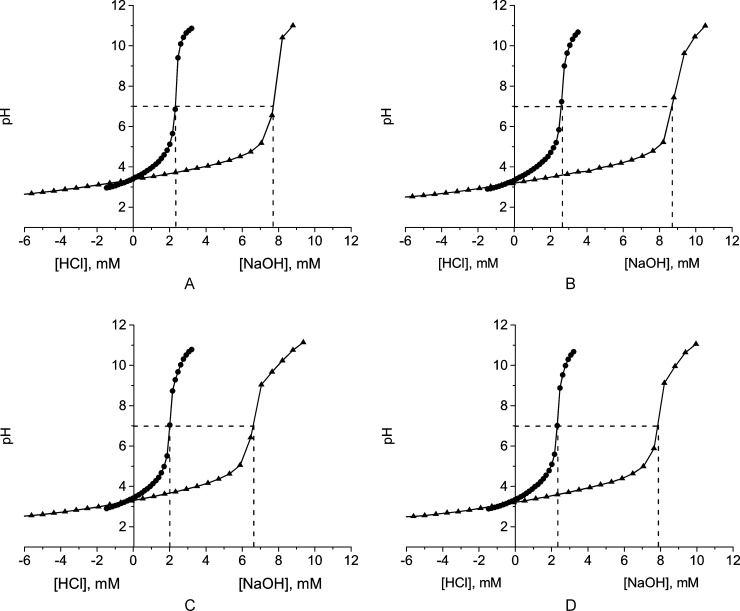
Acid-base titration curves of 0.3 (circle) and 1.2% (triangle) solutions of pectins from different sources.A–pumpkin pectin PP, B–citrus pectin CP, C–apple pectin APA103, D–apple pectin APA104.